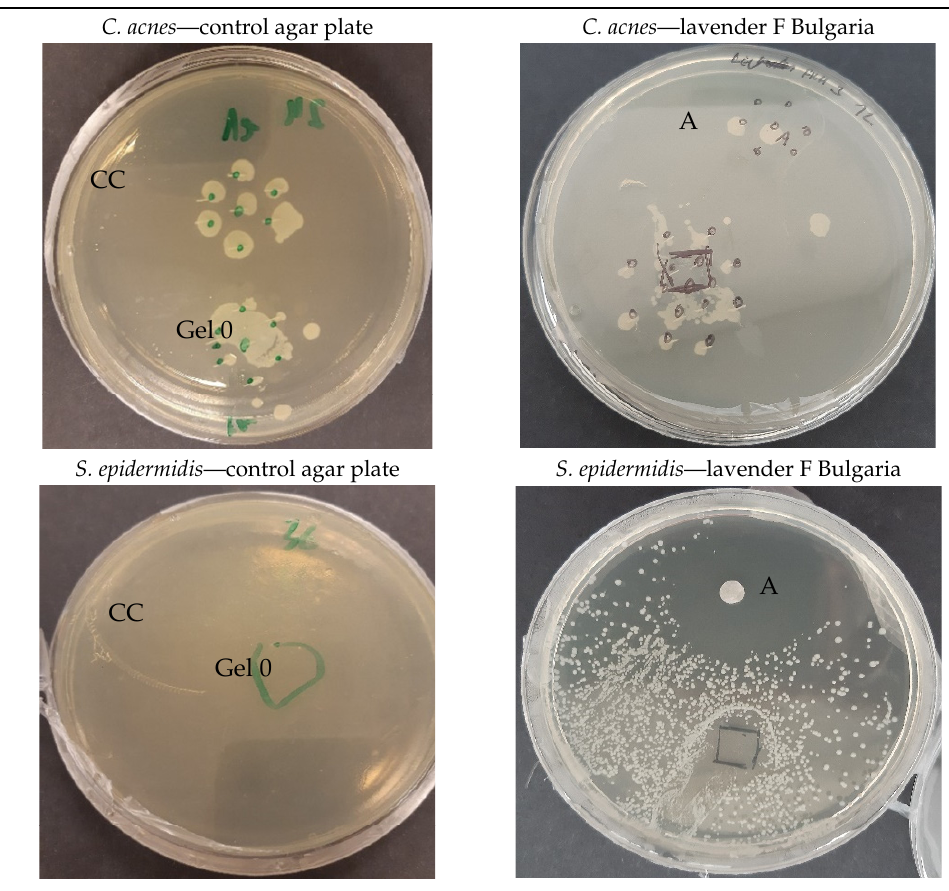
Table 7. Agar diffusion tests of gelatin nanofibers with a 20% addition of EOs.